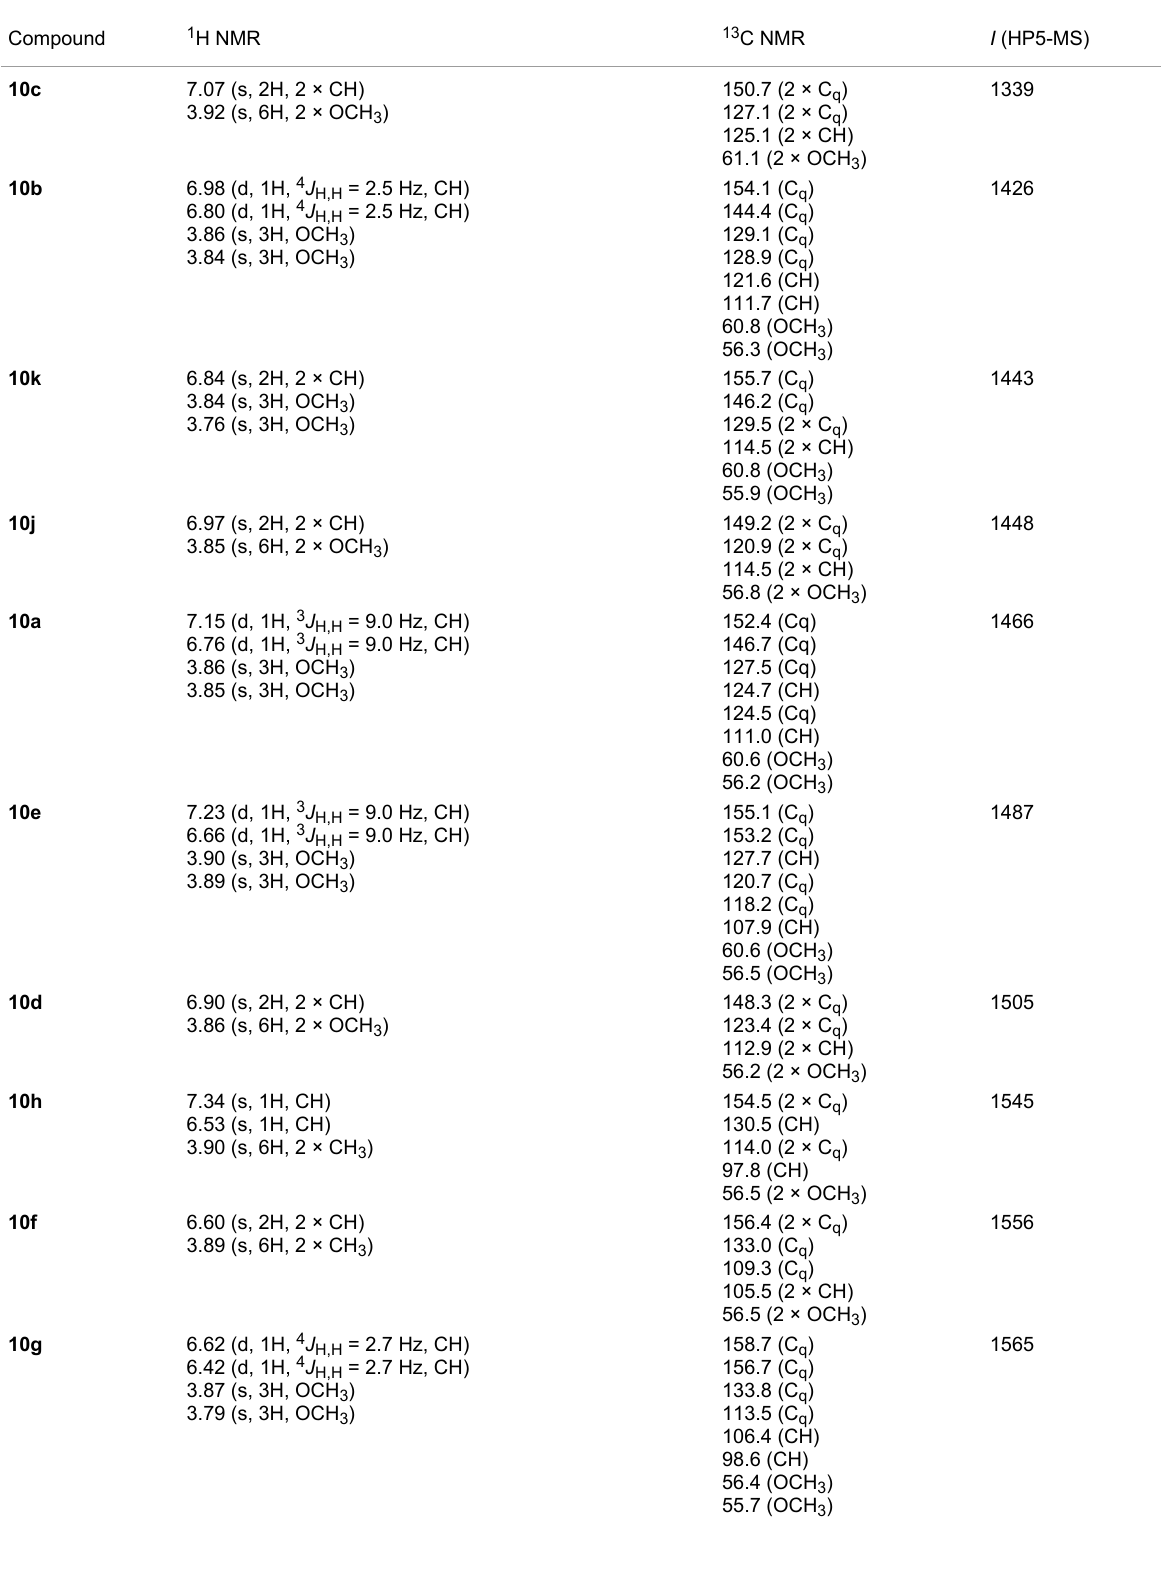
Table 3: NMR spectroscopic data and GC retention indices of all constitutional isomers of dichlorodimethoxybenzene in comparison to natural Y .